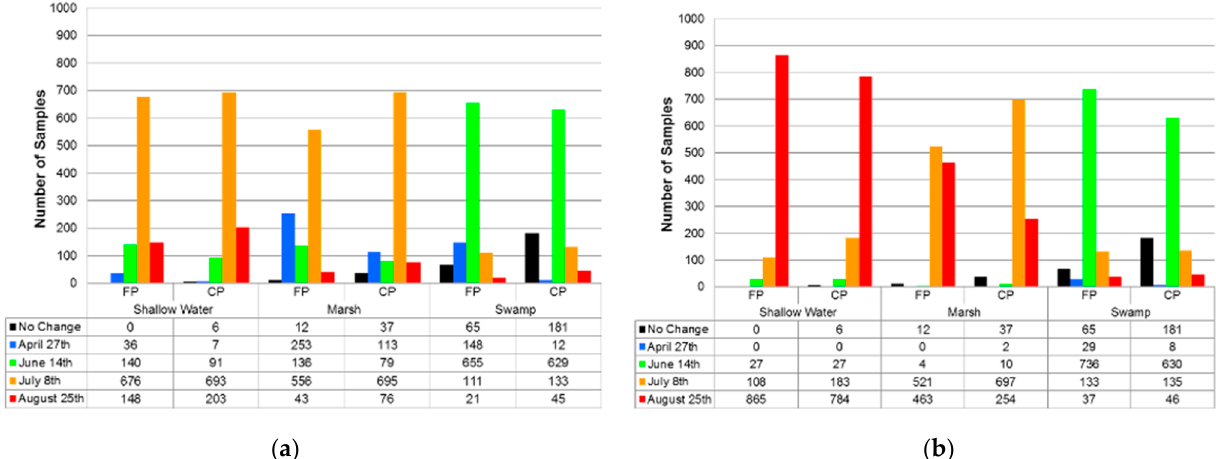
Figure 13. ( a ) Timing of the first detected change for the 1000 randomly selected samples for FP and CP data, ( b ) timing of the last detected for the 1000 randomly selected samples for FP and CP data.